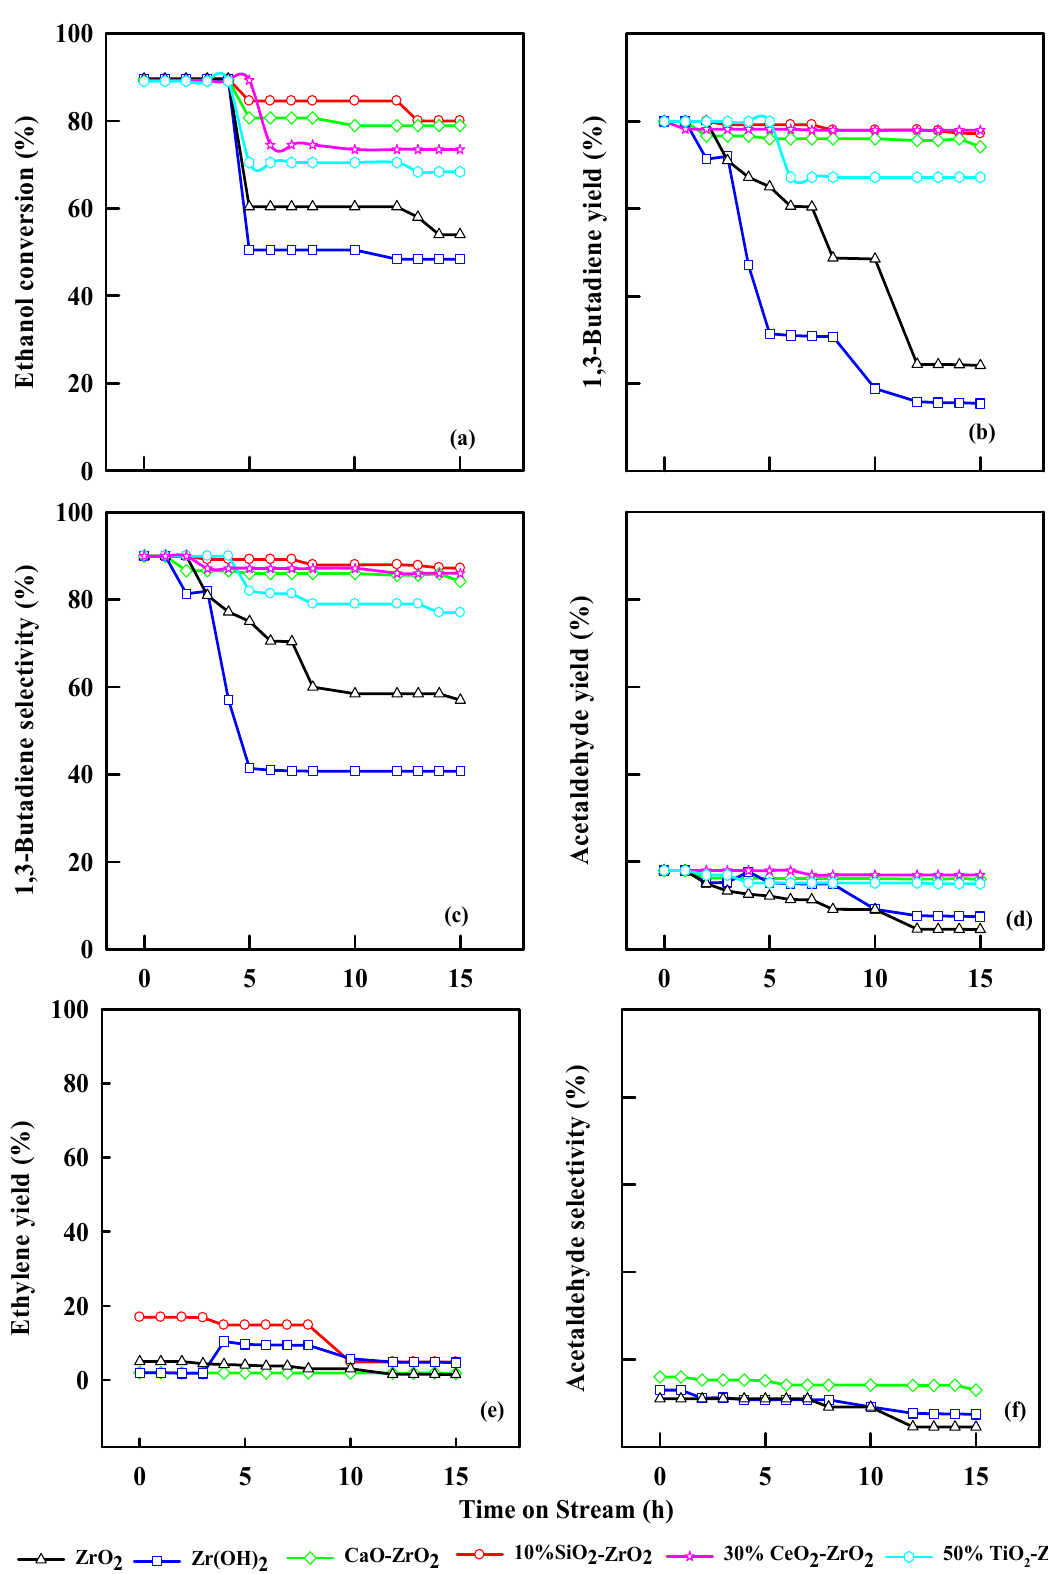
Figure 9. Conversion of ethanol ( a ), yield of 1,3-butadiene ( b ), selectivity of 1,3-butadiene ( c ), yields of acetaldehyde ( d ), yield of ethylene ( e ), and selectivity of acetaldehyde ( f ) with time on streams. WHSV: 2.5 h − 1 , 0.4 g of catalyst, N 2 = 30 mL/min, Temp: 350 °C.